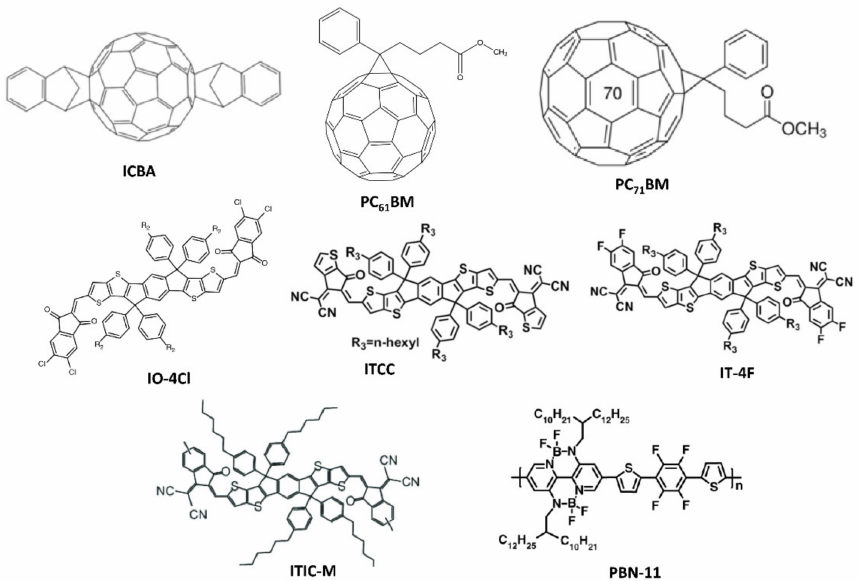
Figure 8. Chemical structures of various widely used fullerene- and non-fullerene-based organic semiconducting acceptor materials in